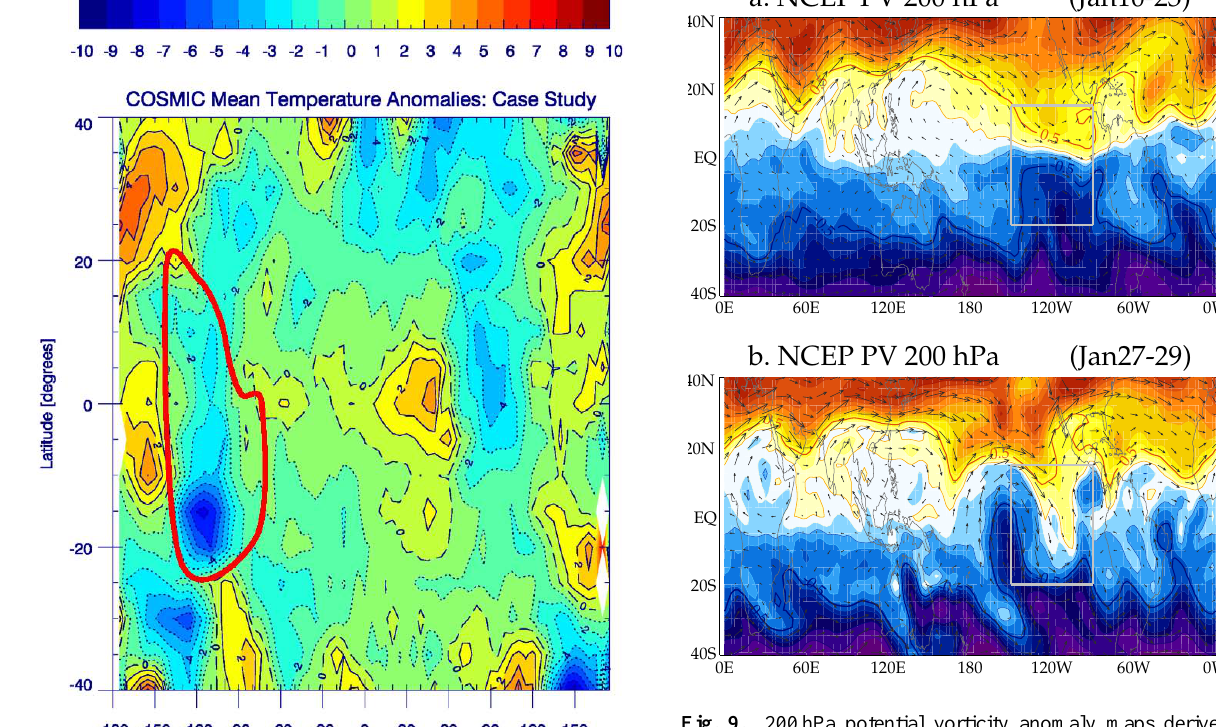
Fig. 9. 200hPa potential vorticity anomaly maps derived from NCEP reanalysis for time periods prior to (10–23 January) and dur- ing (27–29 January) the cloud event. The box highlights the region of the observed cloud and the vectors represent the associated wind